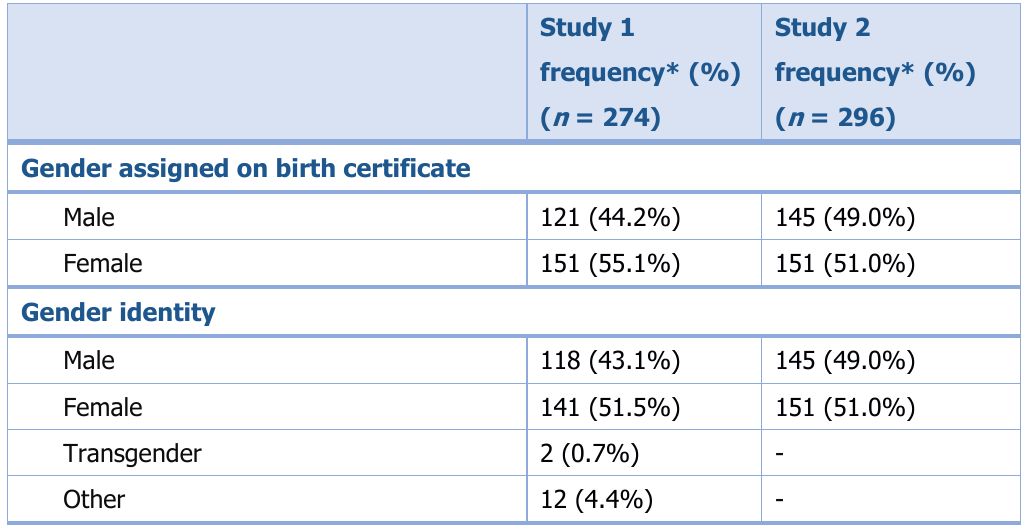
Table 1. Characteristics of Participants in Two Résumé